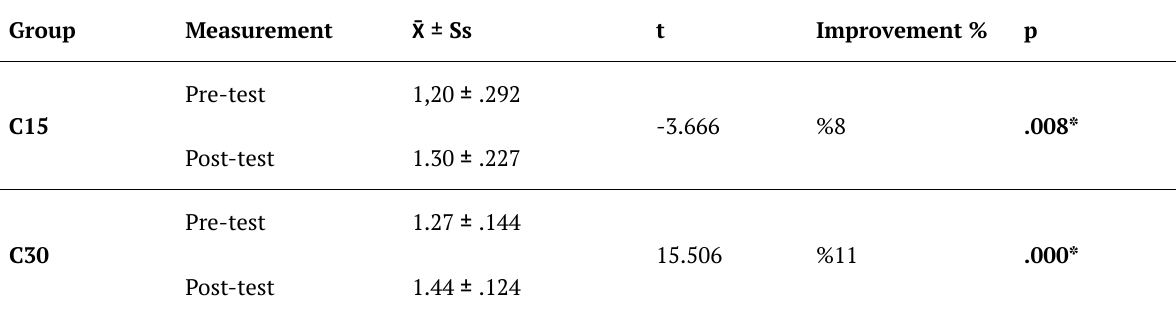
Table 4. T-test results regarding the difference between within-group pre-post test RSI values